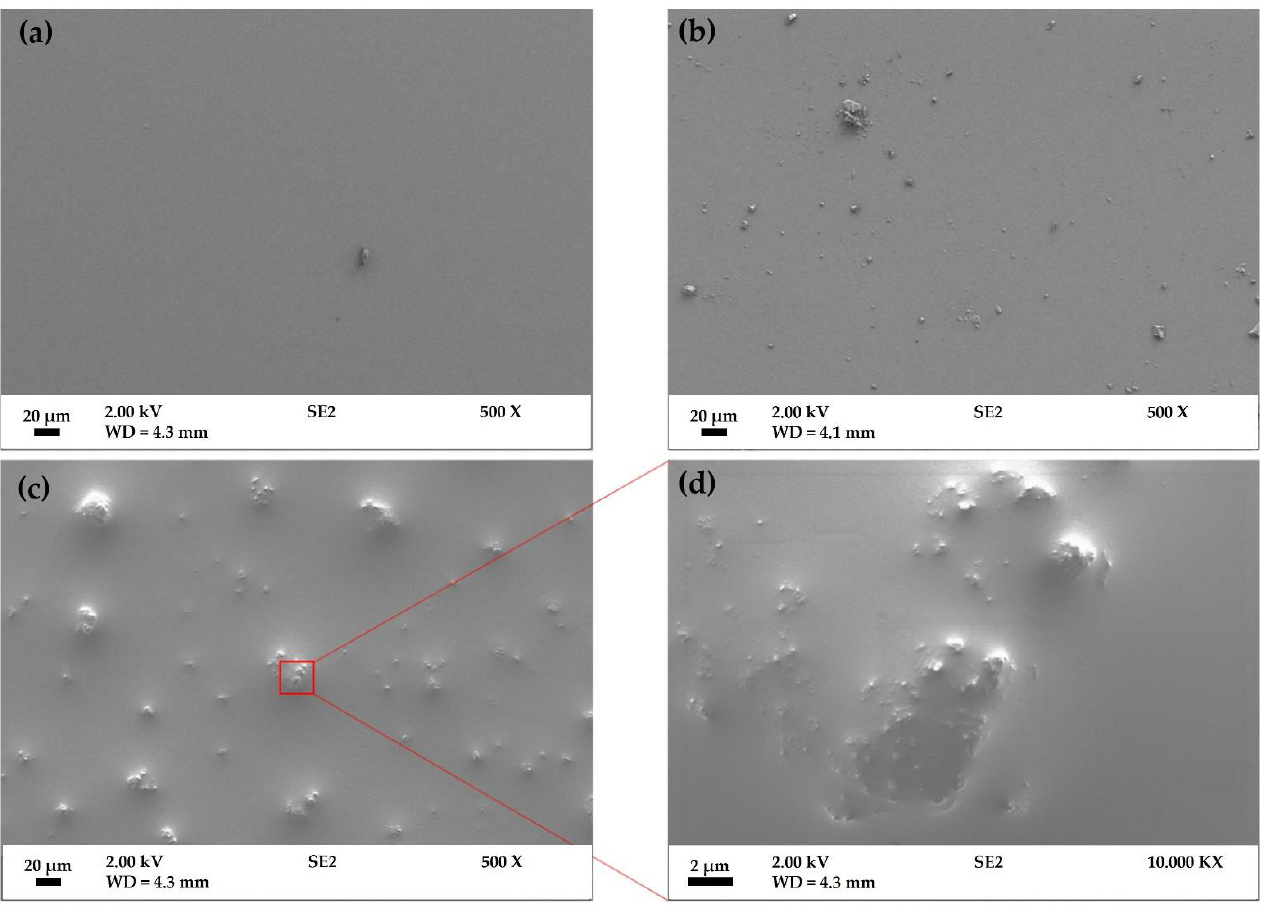
Figure 4. SEM images of glass ( a ), epoxy resin ( b ), GNP composite ( c ), and magnified GNP composite ( d ). The micrographs have a magnification of 500×, except for ( d ), which corresponds to a higher magnification image (10,000×) of the surface area marked in red in ( c ).